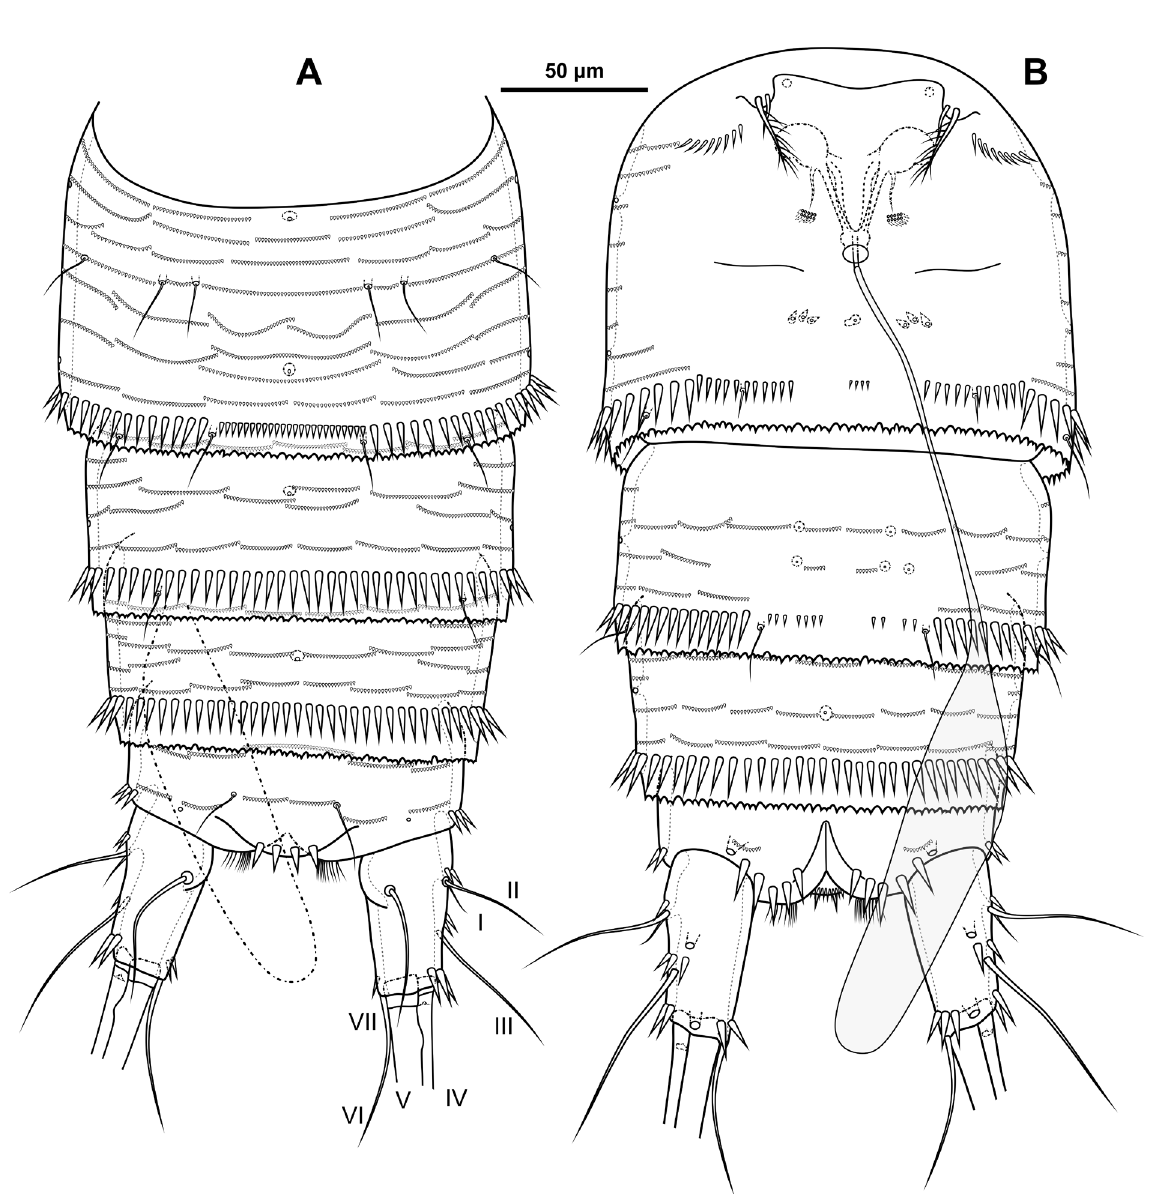
Fig. 3. Canthocamptus waldemarschneideri sp. nov., holotype, ♀ (KFU BP 544/1). A . Abdomen, dorsal view; setae of caudal ramus are labeled with Roman numerals. B . Abdomen, ventral